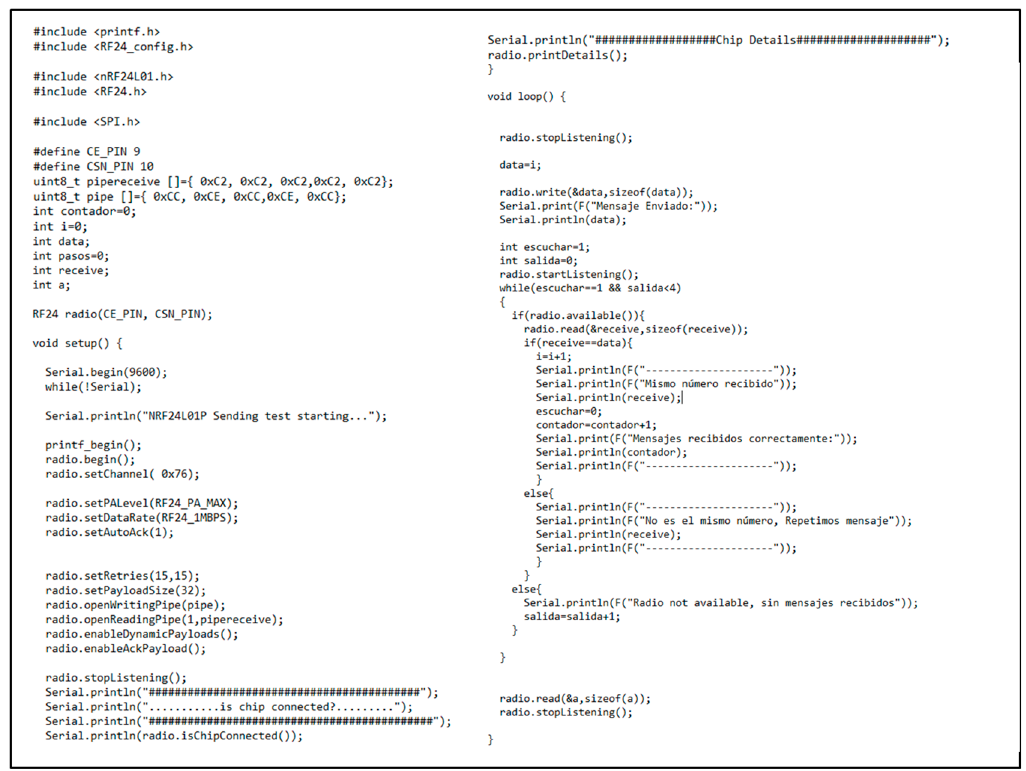
Figure A7. Arduino programming for nRF24L01+ device .